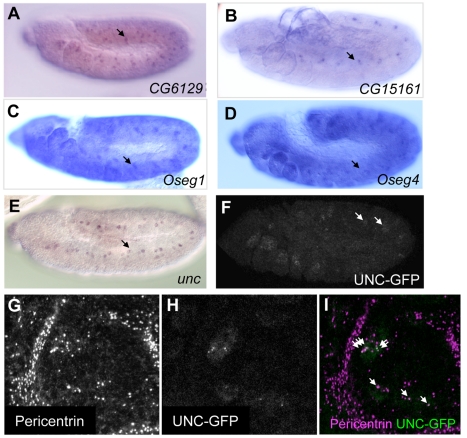
Many differentiation genes are expressed at the neural precursor stage.(A–E) Stage 11 embryos showing early mRNA expression of several ciliogenesis genes. Arrows point to sensory precursor cells or their direct progeny. (A) CG6129 (rootletin homologue). (B) CG15161 (IFT46 homologue). (C) Oseg1 (IFT122 homologue). (D) Oseg4 (WDR35 homologue). (E) unc (basal body protein). (F–I) Expression and localisation of an UNC-GFP fusion protein from a construct in which the unc promotor and ORF are fused to GFP [14]. (F) Stage 11 embryo. UNC-GFP is expressed in sensory precursor cells (arrows). (G–I) Magnification of one segment from (F). UNC-GFP colocalises with the centrosome marker, Pericentrin, in a subset of cells—the Ch precursors. At later stages UNC-GFP localises to the basal body of the ciliary dendrite (unpublished data).